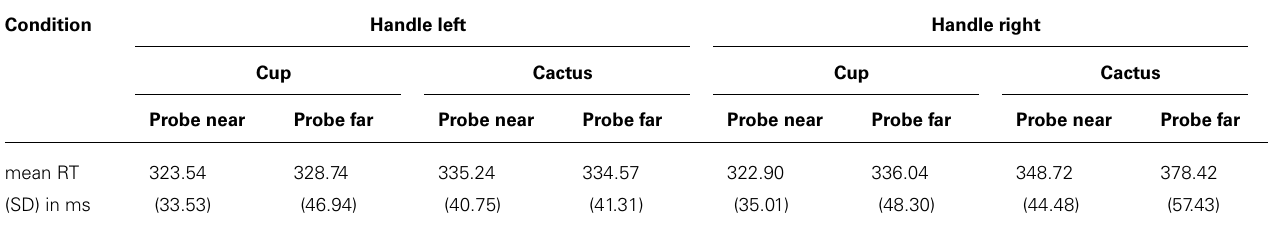
Table 2 | Mean reaction times in all eight conditions, Experiment 2.